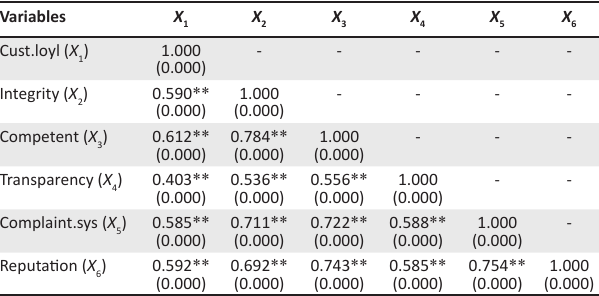
TABLE 8: Pearson’s correlation between customer loyalty and corporate governance practices (domains).